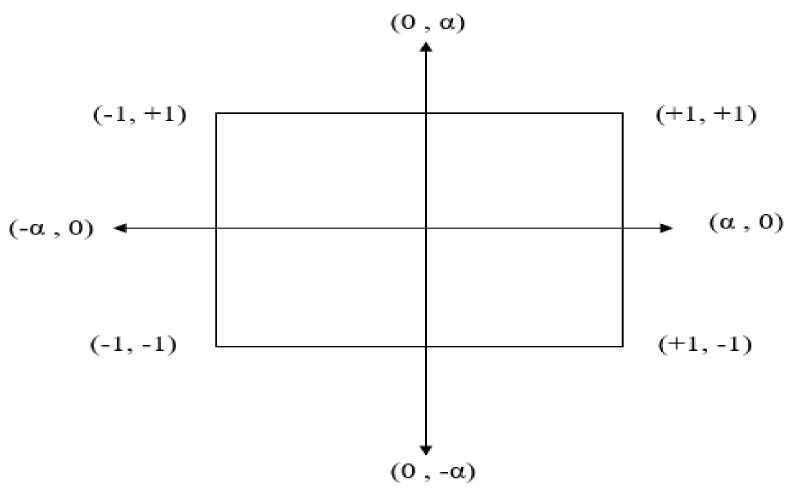
Figure 2. Central composite design for two